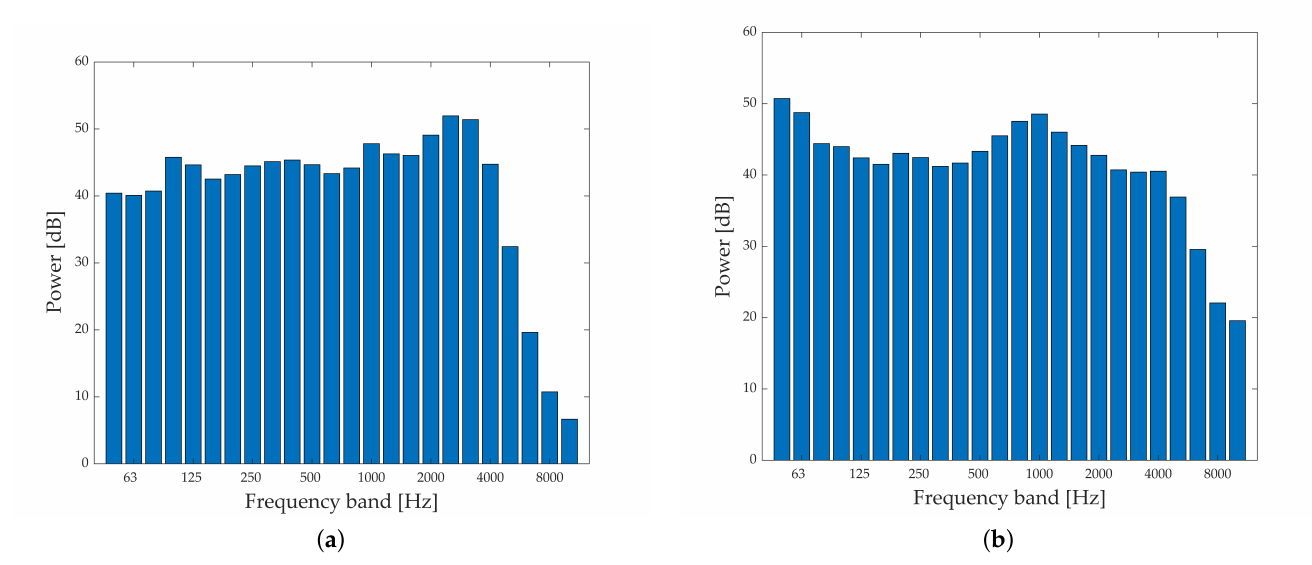
Figure 2. 1/3 Octave band of test stimuli (60 dB): ( a ) Aircraft Noise; ( b ) Road Traffic